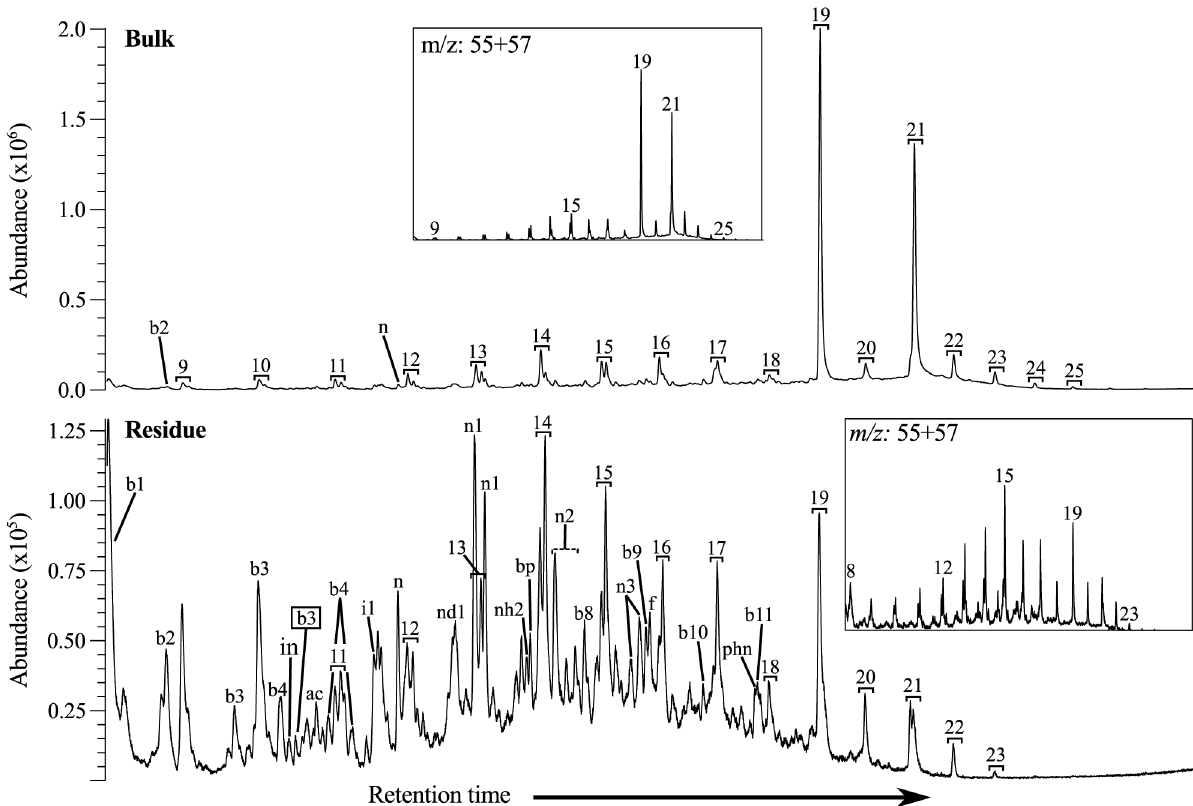
Fig 5. Py-GCMS total ion current and m/z 55+57 chromatograms of the bulk and Residue of UOM-232. The insets are not to scale. Black brackets represent n- alkane/ n- alkene doublets (numbers indicate carbon chain length), ac acetophenone, bp biphenyl, f fluorene, in indane, phn phenathrene/ anthracene; and bx benzene and nx napthalene derivatives, where x represents the number of carbon atoms in the alkyl group. A black outline indicates the presence of a double bond.